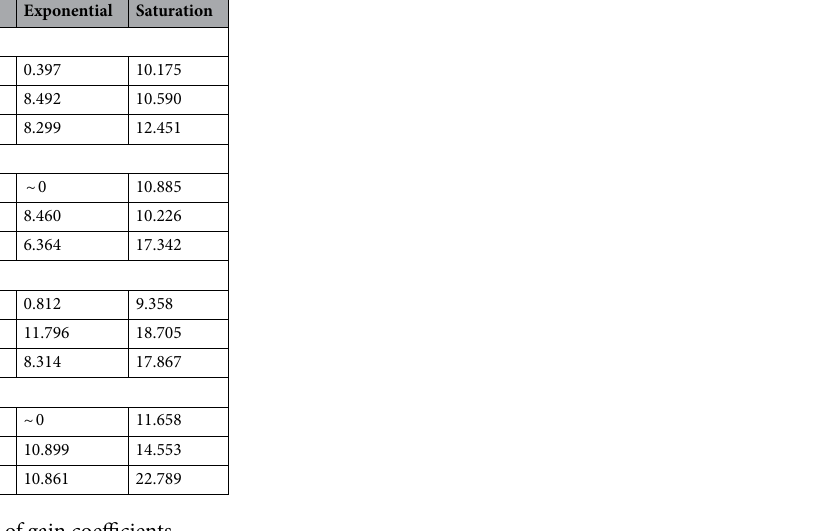
Table 1. Summary of gain